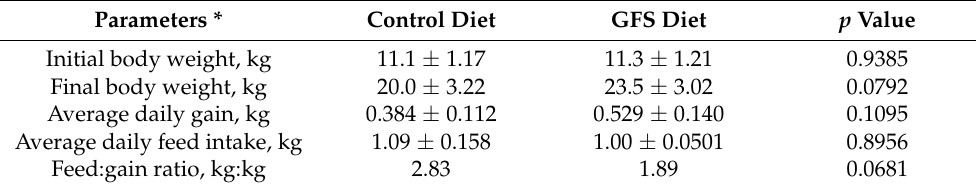
Table 4. The effect of the diets on the performance of piglets. Parameters *